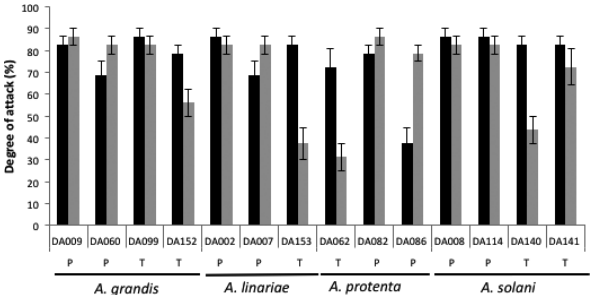
Figure 6. Disease severity evaluated using a visual rating scale (0-100%) at 15 days post-inoculation of tomato (black bars) and potato (grey bars) leaves with isolates representing the four large- spored Alternaria species. Letters (P or T) under the isolates identi- ties refer to the host of origin (Potato or